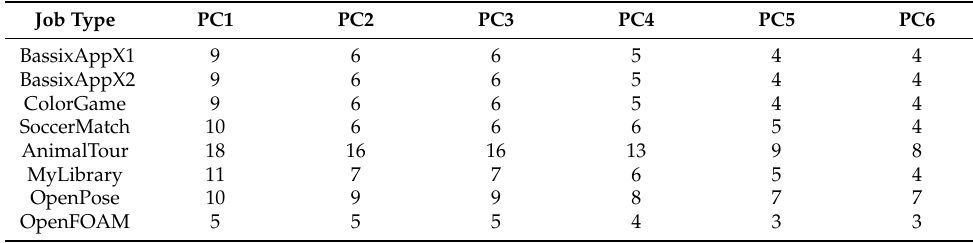
Table 3. Constant CPU time to start jobs (s).